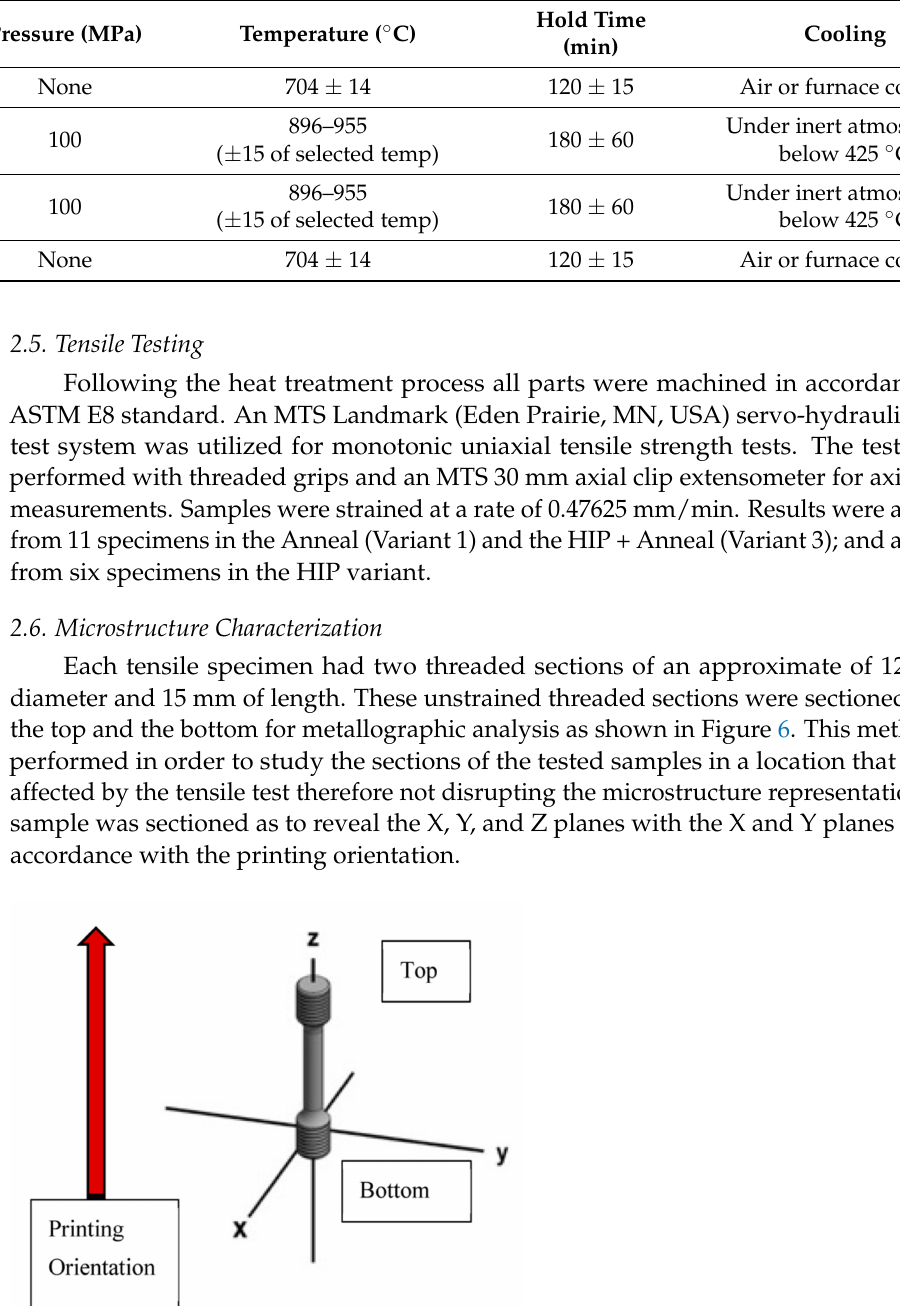
Table 2. Hot isostatic pressing and annealing parameters.